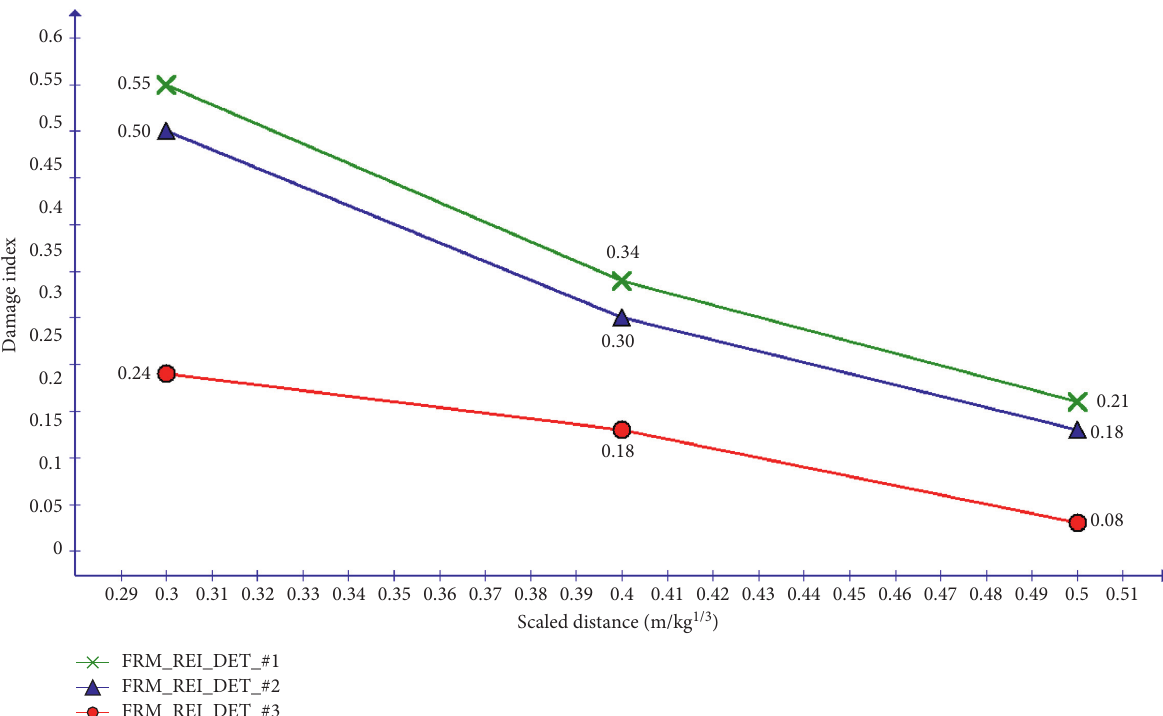
Figure 25: 1 st story column damage index values for different reinforcement detailing provisions under various scaled distances.